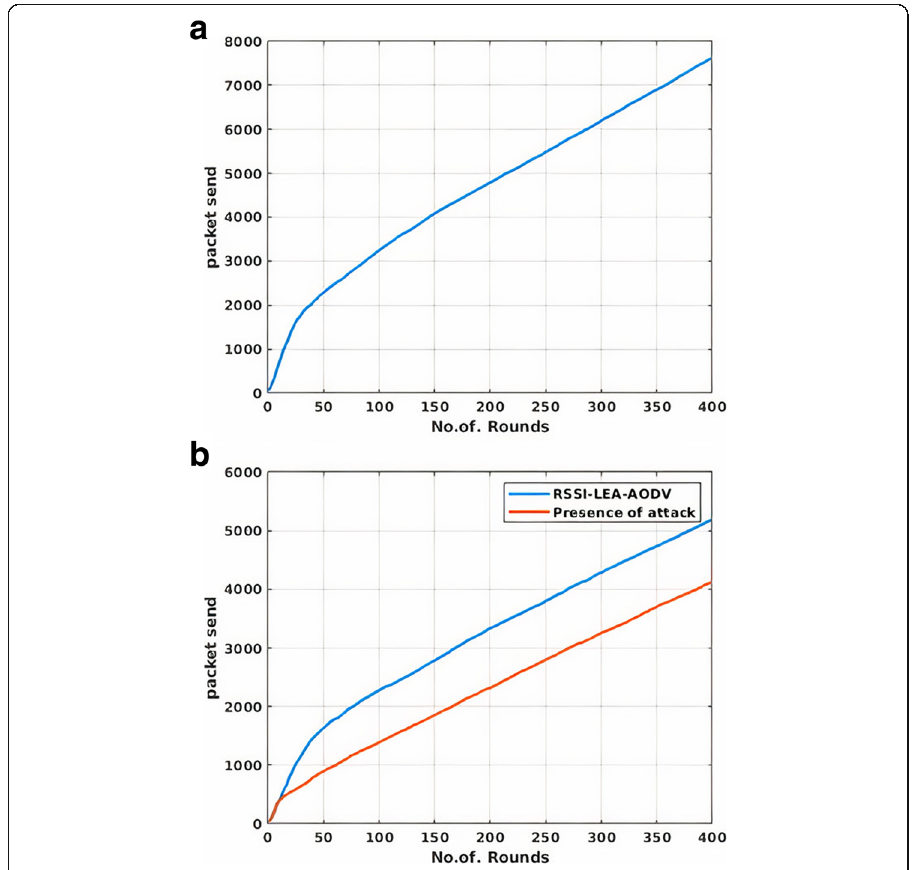
Fig. 14 a Packet send of the network without a Sybil attack. b Performance comparison of the packet